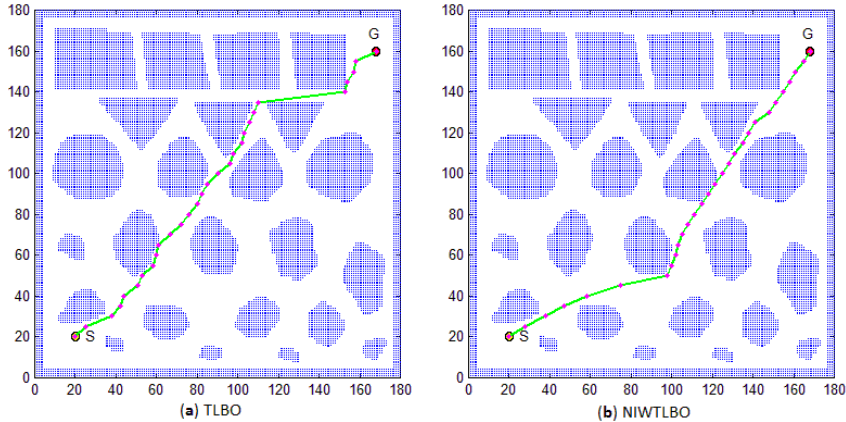
Figure 8. Path planning in the scenario of var_density3. D = 27. ( a ) The result of the TLBO; ( b ) The result of the NIWTLBO.